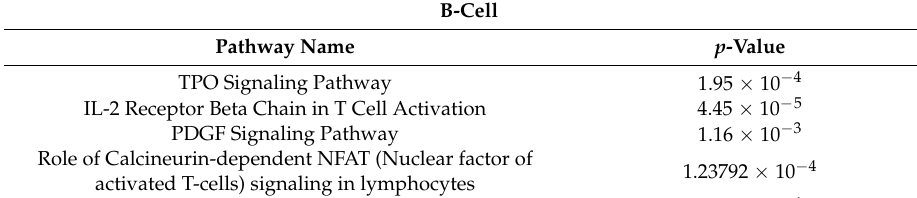
Table 2. Enriched specific signaling pathways in the gene regulatory networks of immune